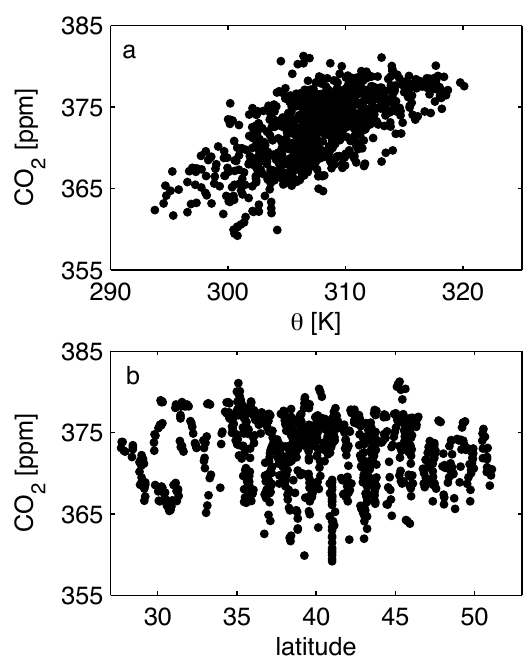
Fig. 10. Free tropopsheric [CO 2 ] measured during INTEX-NA plotted against (a) θ at 700hPa determined from regional reanal- ysis data and (b) latitude. [CO 2 ] better correlates with potential temperature because synoptic activity obscures the north-south gra- dient while a dynamical coordinate reveals